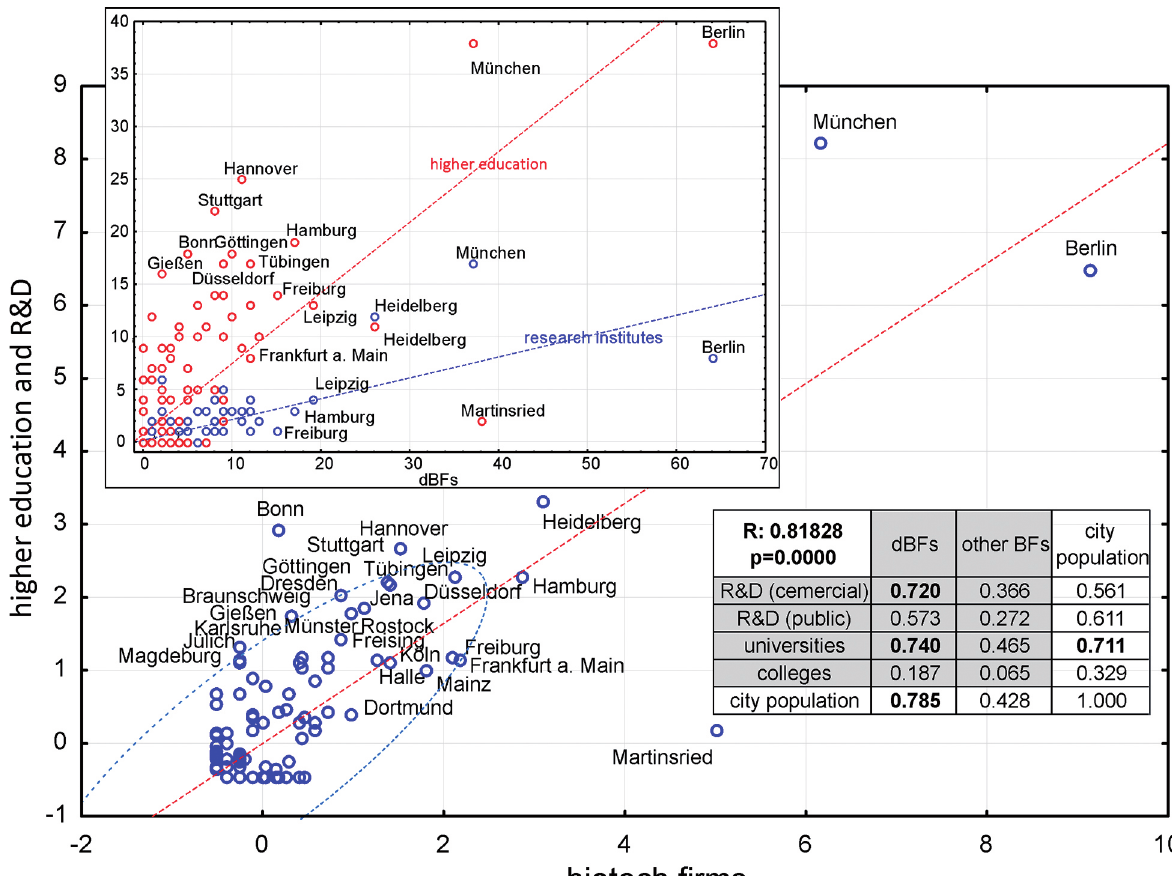
Fig. 12. Dependence between the location of biotech production and R&D centres in Germany, 2013 Source: own calculations based on the Internet portal